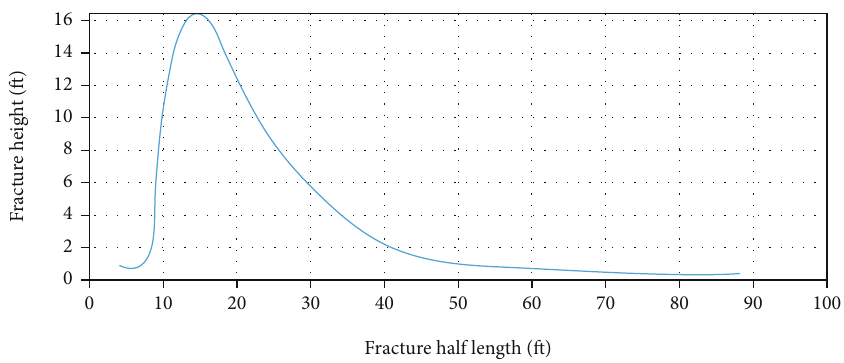
Figure 10: Con fi guration of LCM pile in fracture when the lost circulation is controlled.